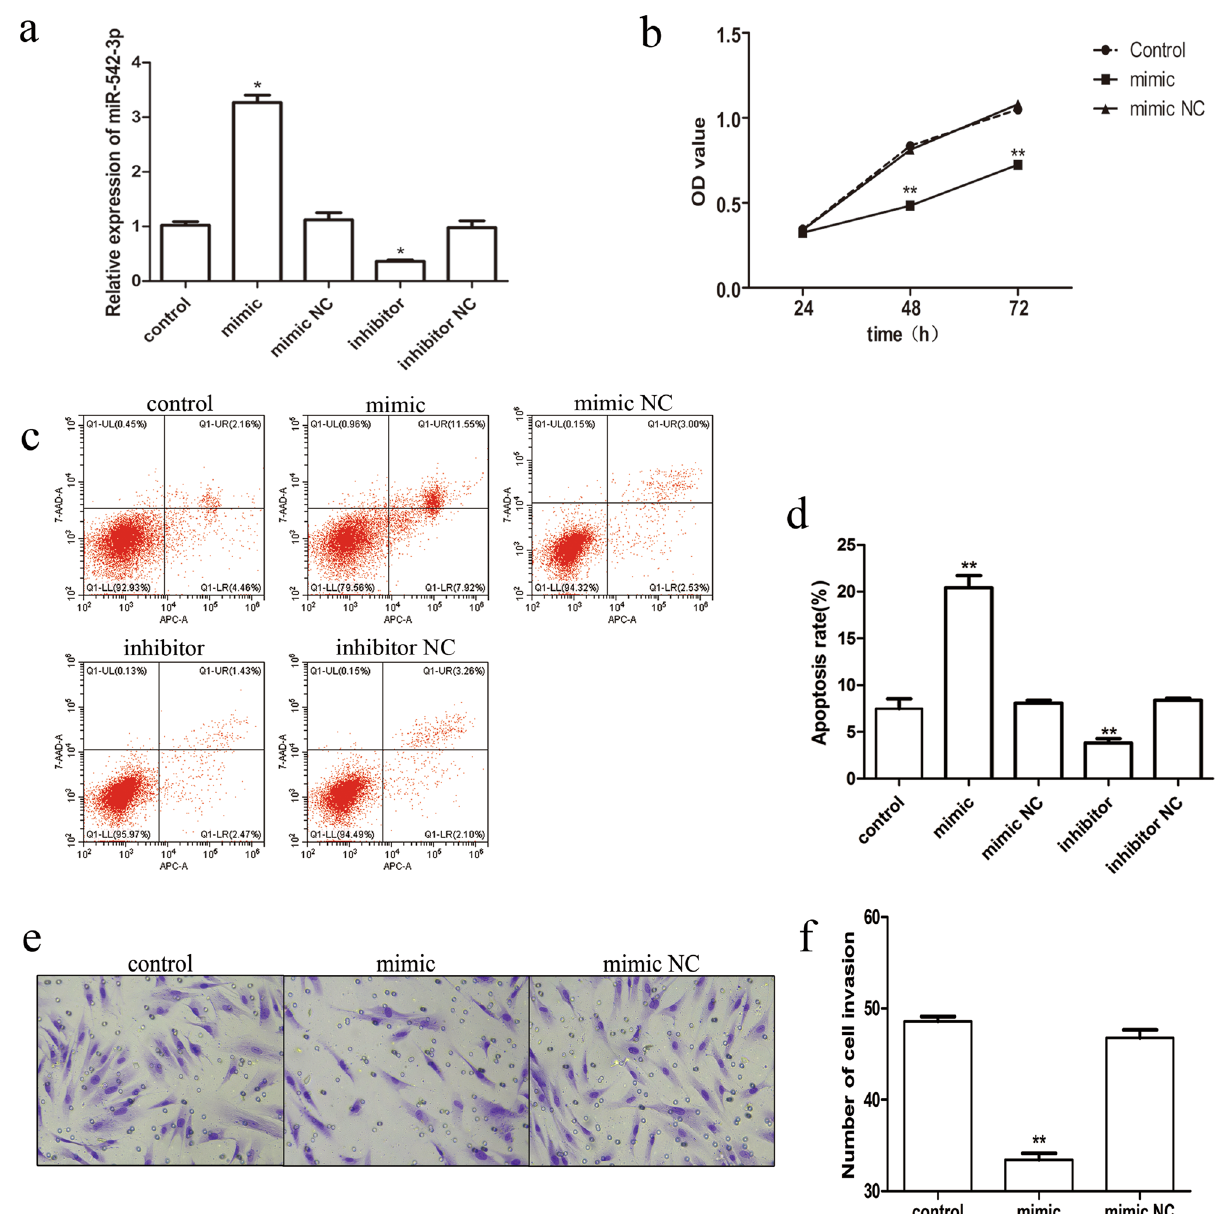
Figure 2. Effect of miR-542-3p overexpression on decidualizing HESCs. ( a ) q-PCR analysis of miR-542-3p levels in HESCs transfected with a miR-542-3p mimic or mimic NC or inhibitor or inhibitor NC and decidualized for 3 days. ( b ) MTT assay analysis of HESCs proliferation in control or miR-542-3p mimic or mimics NC groups and decidualized for 3 days. ( c , d ) Analysis of percent apoptosis of HESC cells by Flow cytometric analysis in control or miR-542-3p mimic or mimics NC or inhibitor or inhibitor NC groups and decidualized for 3 days. ( e , f ) Representative images (200X) of Transwell assay showing invasion ability of HESC from control or miR-542-3p mimic or mimics NC groups and decidualized for 3 days. Significance is marked as **p < 0.01. Values are expressed as mean ± SD of three independent experiments ILK as a miR-542-3p direct